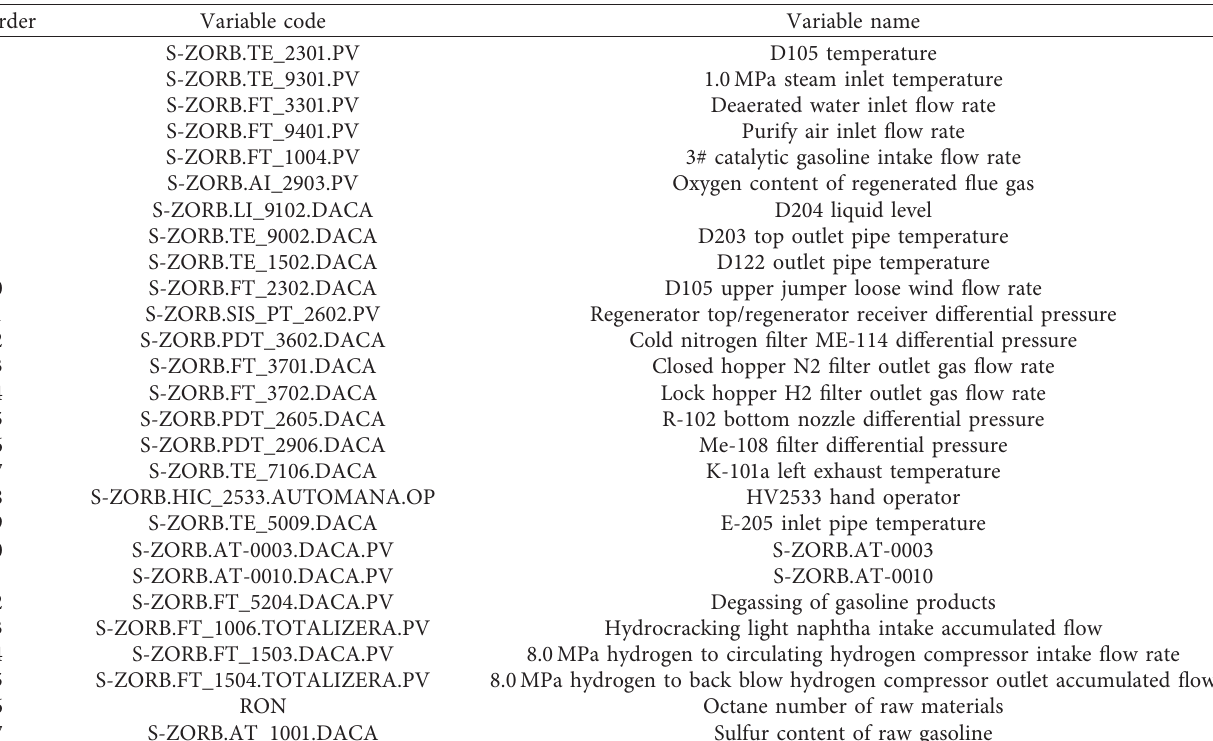
Figure 3: Main variable correlation coefficient thermodynamic diagram after deletion. Table 2: Main variables after